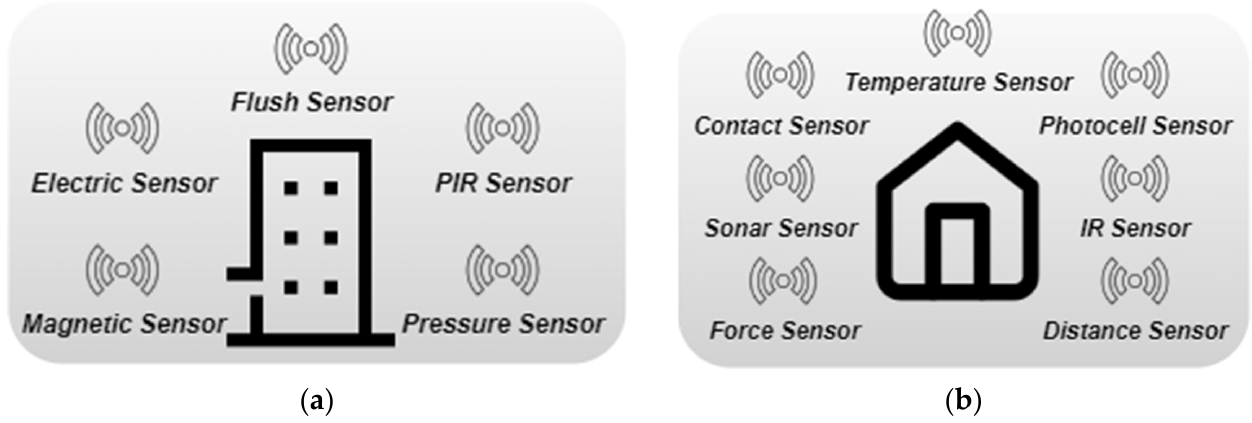
. Figure 11. User’s surrounding environments ( a ) at t 1 and ( b ) at t 2 . and ( b ) at 𝑡 1 2